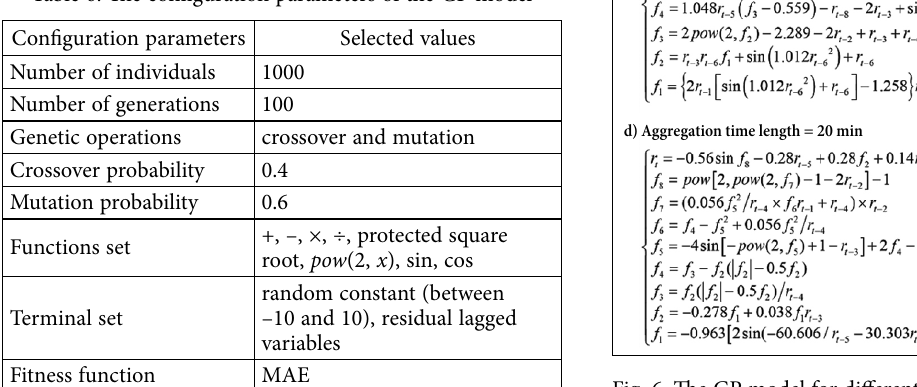
Fig. 6. The GP model for different time-aggregations at Site A Table 7. Autocorrelation check for white noise for the 5-min hybrid model at Site